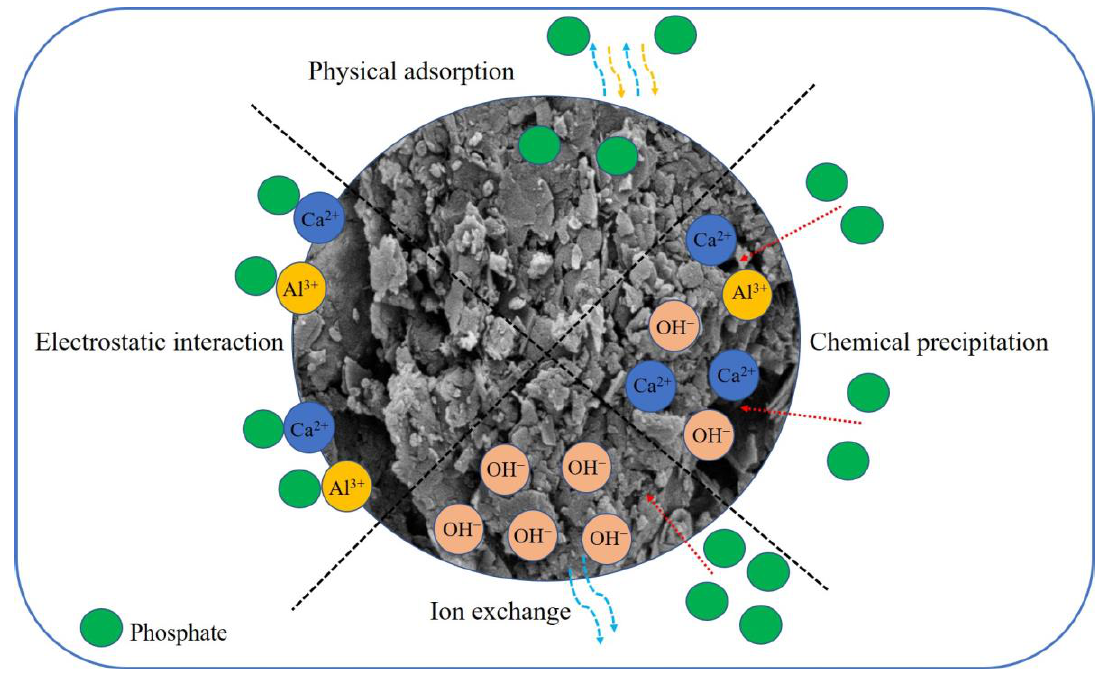
Figure 6. The mechanisms of phosphate adsorption of Al-CG.